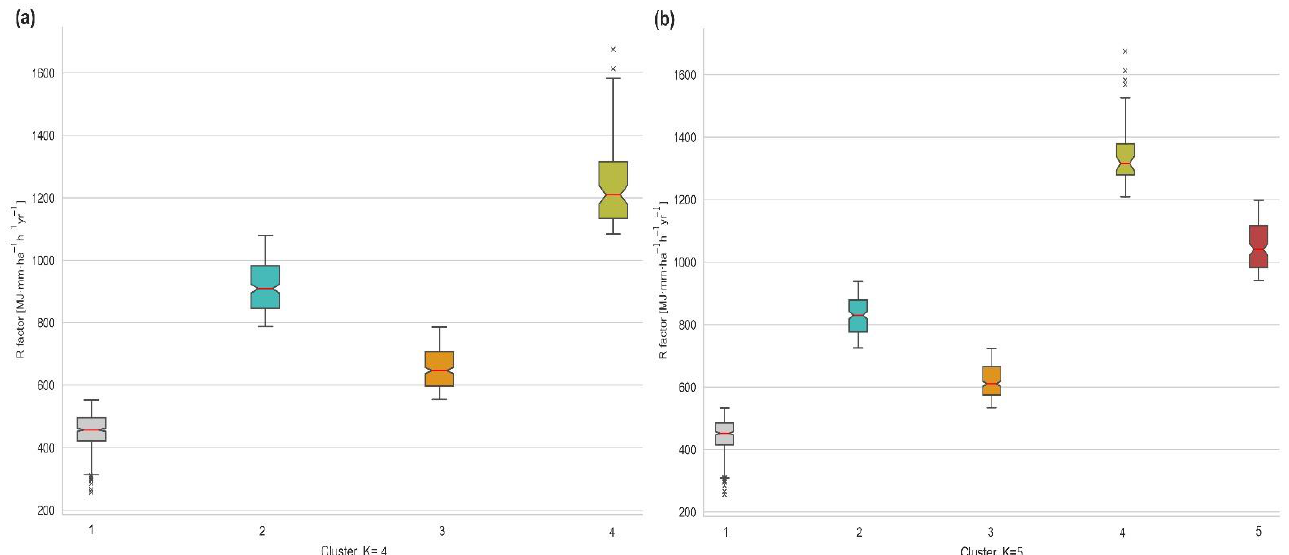
Figure 10. As in Figure 9, except for the RUSLE2 methodology with light grey, dotted lines represent R-factor values >800 mm ha − 1 h − 1 yr − 1 , and dark grey dotted lines are R-factor values >1200 mm ha − 1 h − 1 yr − 1 .